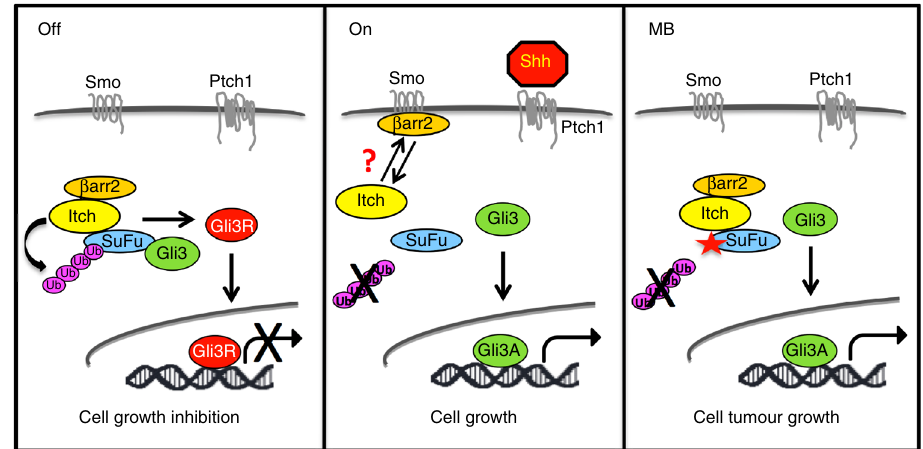
Fig. 9 Model of the Itch/ β -arrestin2-dependent regulation of the SuFu/Gli3 complex function. When Hh pathway is OFF, Itch, coadjuvated by the protein adaptor β -arrestin2, ubiquitylates SuFu. This event does not lead to SuFu degradation, but increases the association between SuFu and Gli3. In this way Gli3 is protected from SPOP-dependent degradation and is cleaved into a repressor form (Gli3R) that inhibits Hh target gene transcription and cell growth. When Hh pathway is switched ON, β -arrestin2 dissociates from the SuFu/Itch complex, thus abrogating Itch-dependent SuFu ubiquitylation. This process induces the dissociation of the Gli3-SuFu complex and impairs Gli3R formation, thereby leading to Hh pathway activation and sustained cell growth. Alterations in this mechanism, caused by SuFu mutations that make it insensitive to Itch-dependent ubiquitylation, are responsible for MB